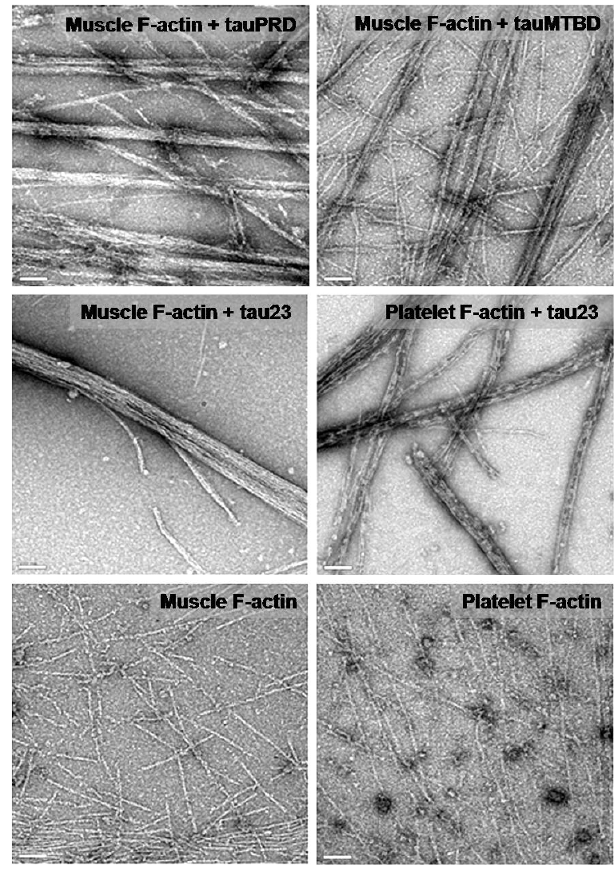
Figure 9 Electron microscope images of F-actin incubated with tauPRD . F-actin was incubated with tauPRD, tauMTBD and tau23 as described in Figure 4 and visualized with electron microscope. F-actin alone was shown as nega- tive control. Bars in panels are 100